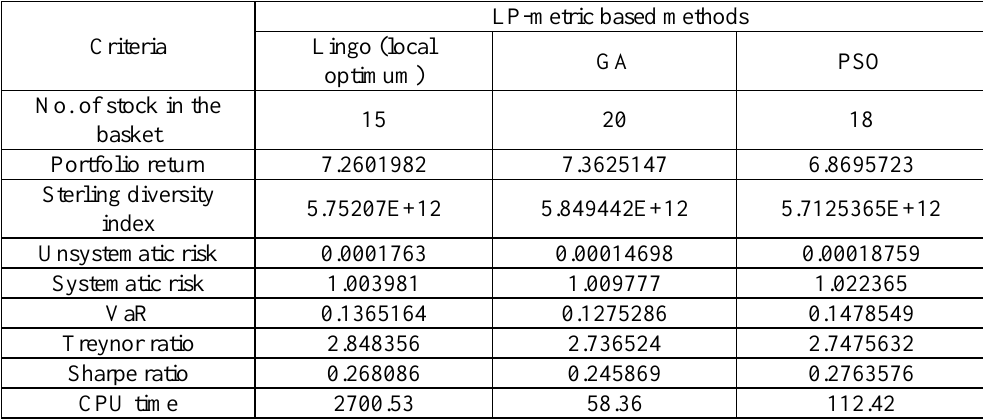
Table 7. Comparison of related criteria in three